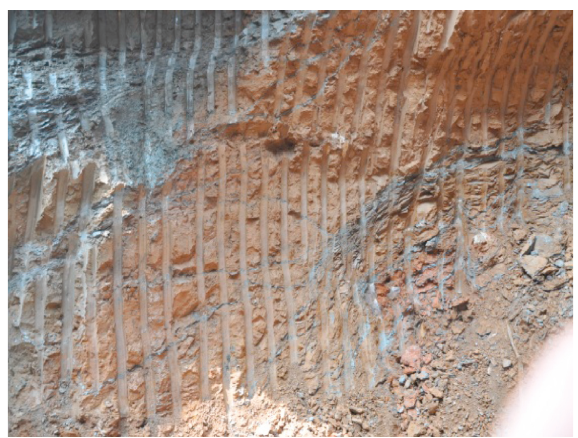
Figure 11: On-site